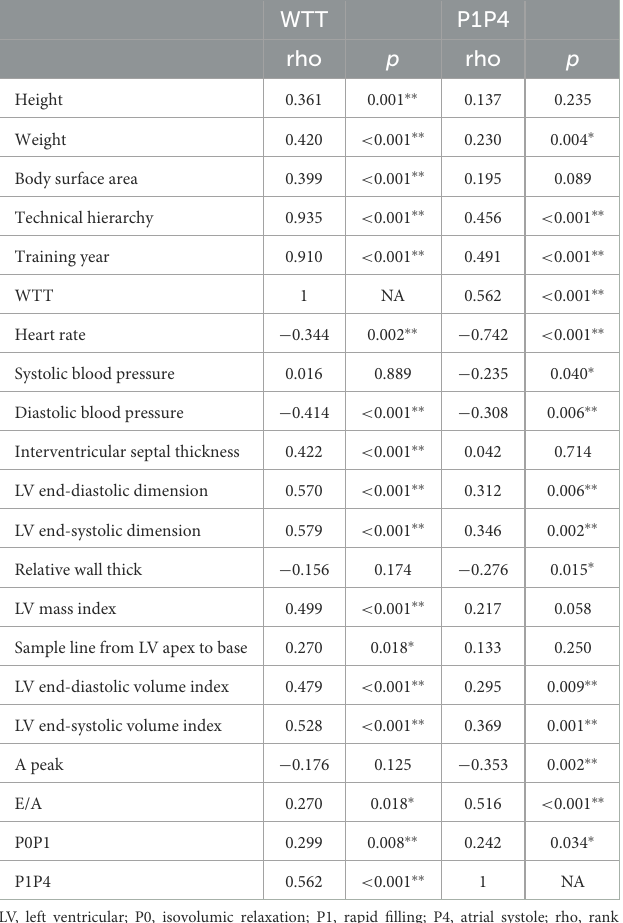
TABLE 3 Correlation of WTT and P1P4 with basic physiological information, echocardiographic and diastolic IVPD